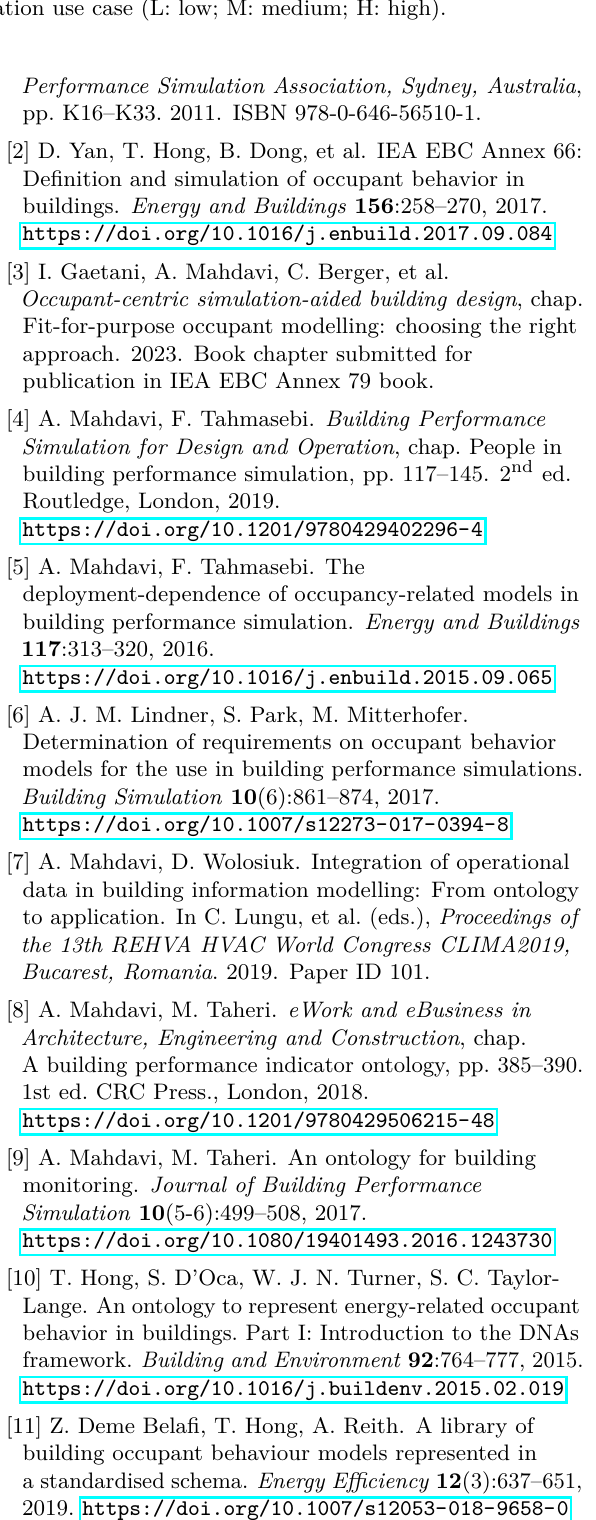
a function of the simulation use case (i.e.,